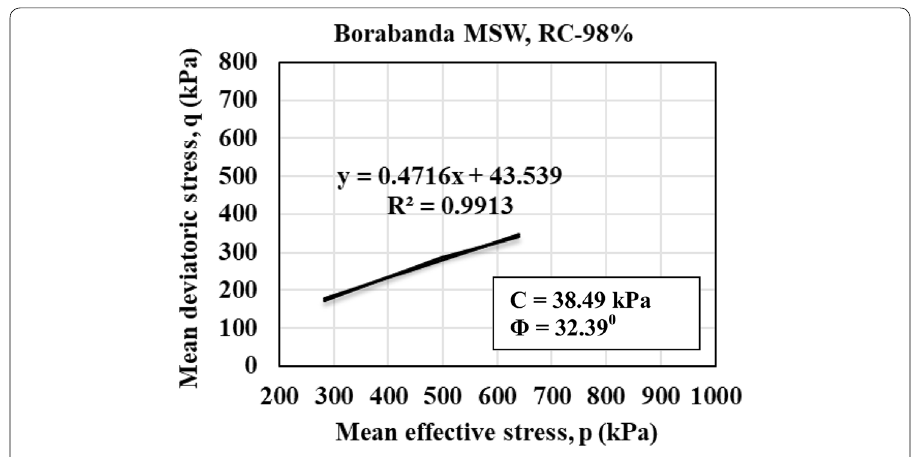
Fig. 33 p–q diagram of Borabanda MSW at RC-98%